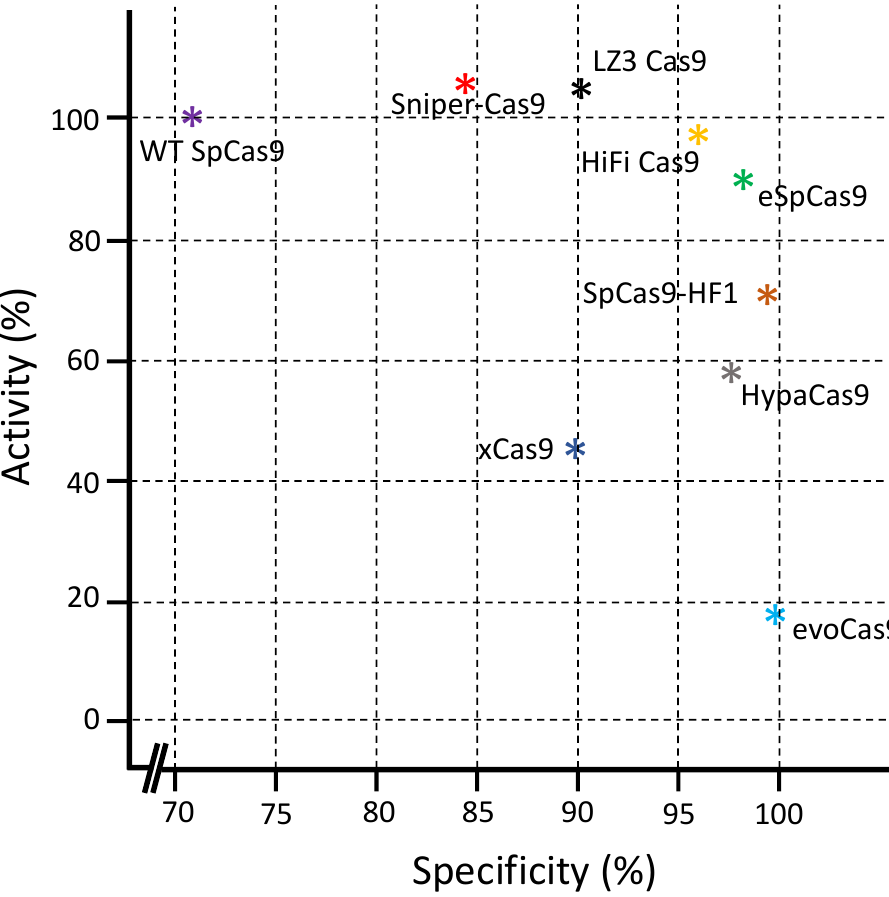
Figure 5. Specificity and activity scores for some tested SpCas9 variants [61].